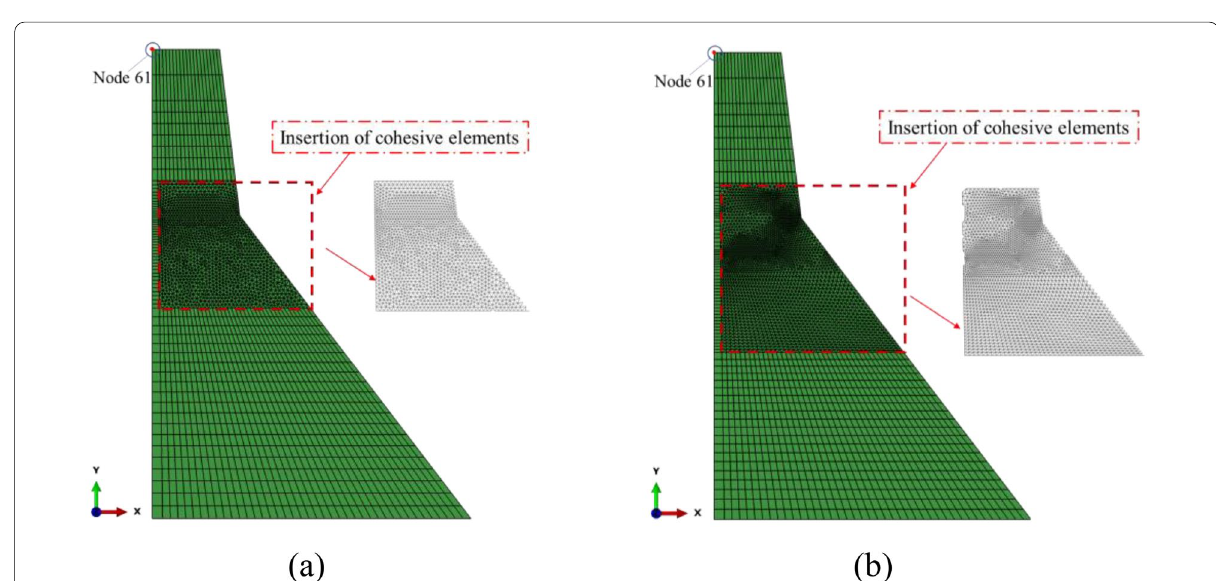
Fig. 23 Numerical models of the Koyna gravity dams ( a ) without longitudinal crack and ( b ) with a penetrating longitudinal